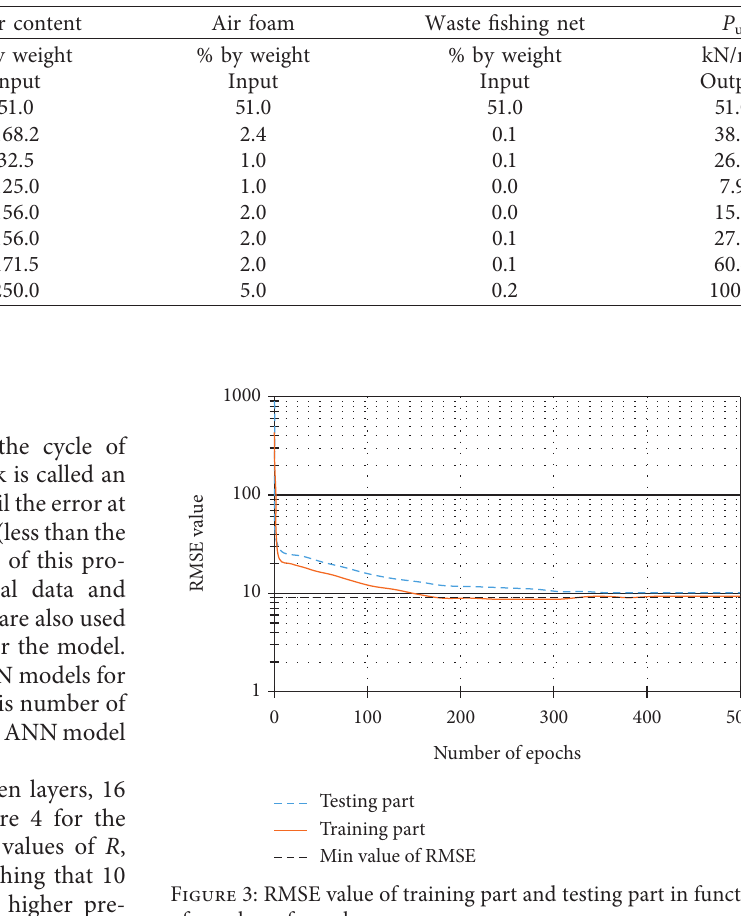
Table 1: Initial statistical analysis of the dataset.